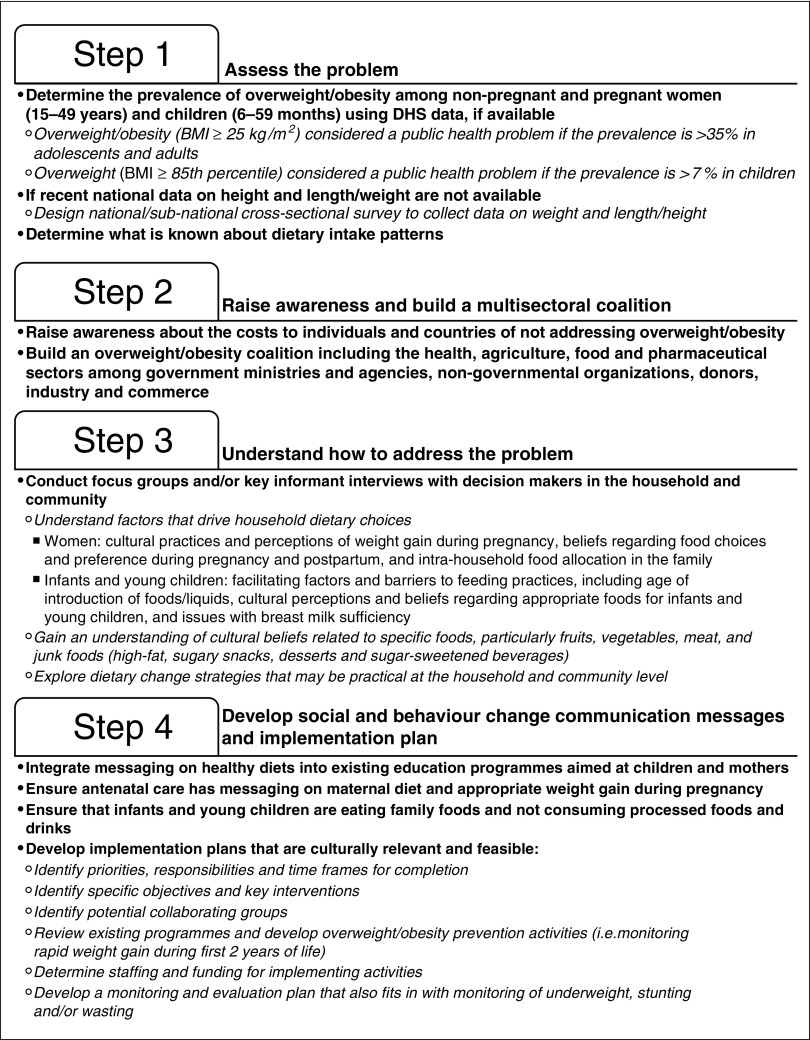
Step-by-step implementation guide to address overweight and obesity in low- and middle-income countries (DHS, Demographic and Health Survey)